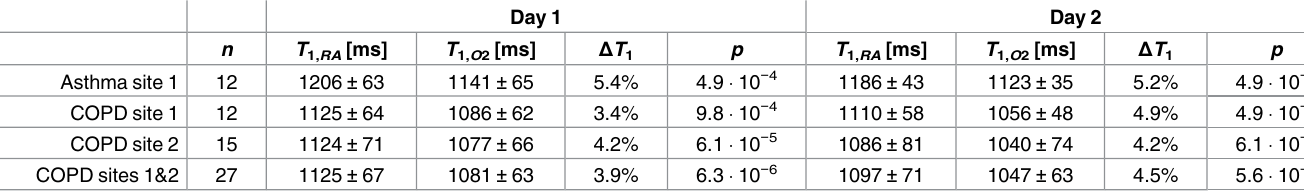
Table 1. Median T 1 values over the entire lungs of patients.